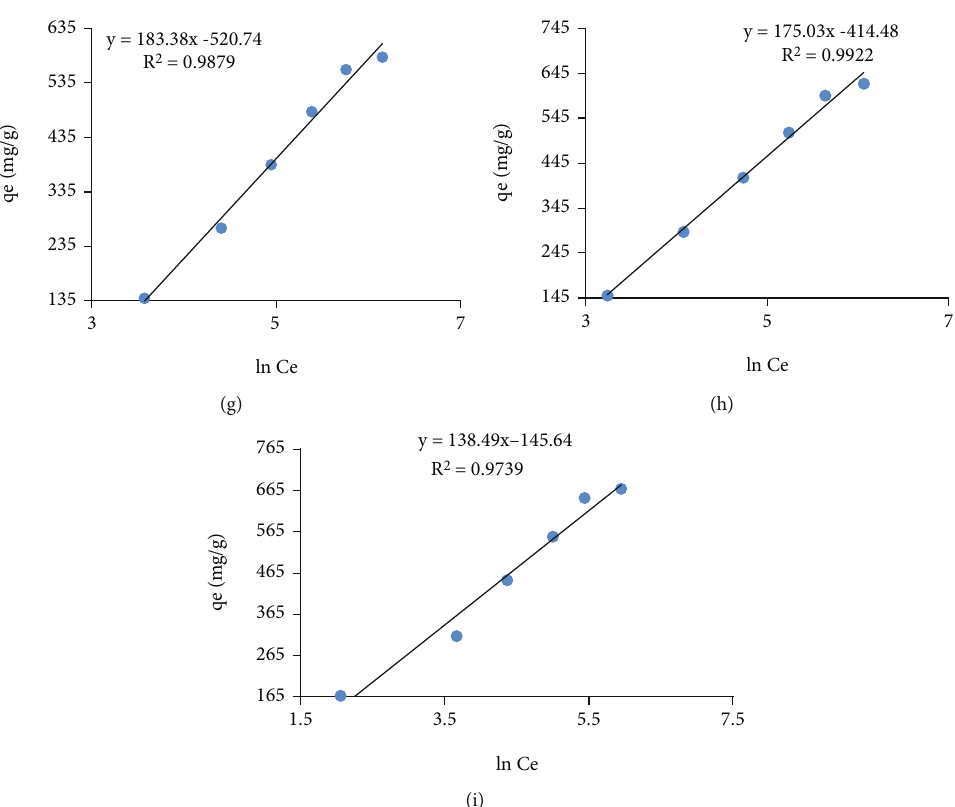
Figure 9: Adsorption isotherms for safranin adsorption on the GA/AM (adsorbent 0.01g, time 60 min, dye solution 10mL, pH 11, temp 293,313, 333K). Langmuir isotherm at (a) 293K, (b) 313K, and (c) 333 K; Freundlich isotherm at (d) 293K, (e) 313K, and (f) 333 K; and Temkin isotherm at (g) 293K, (h) 313 K, and (i) 333